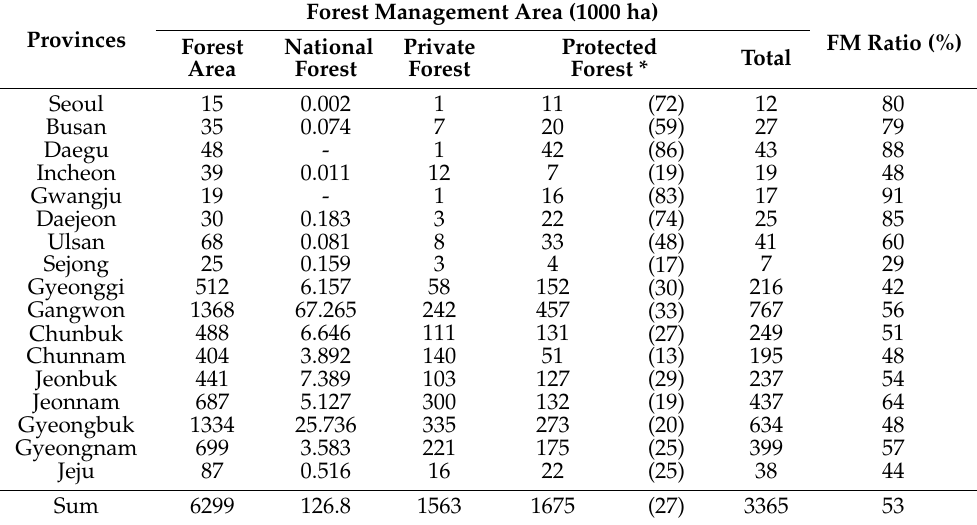
Table 4. Forest management ratio by province in 2019. Forest Management Area (1000 Provinces